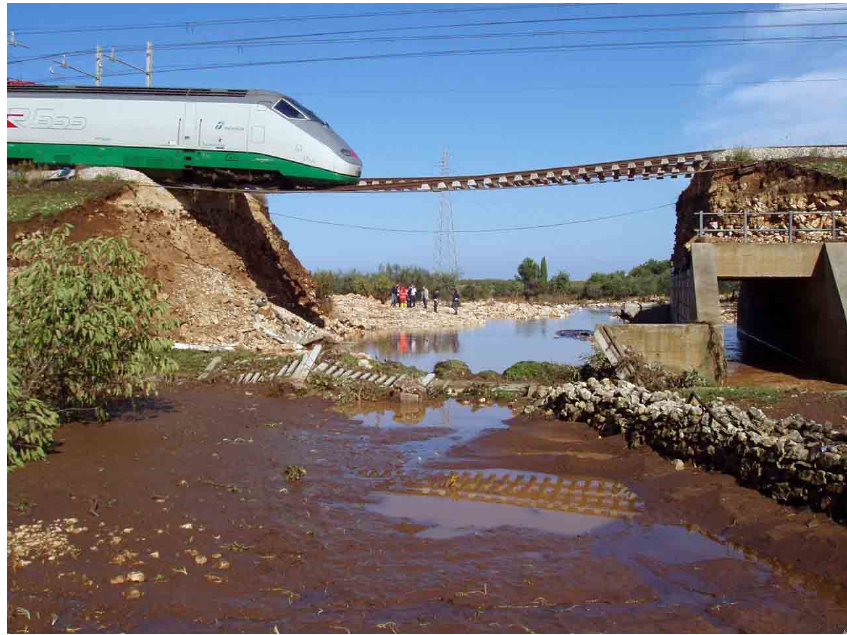
Figure 5. Failure of the railway track Bari – Taranto,